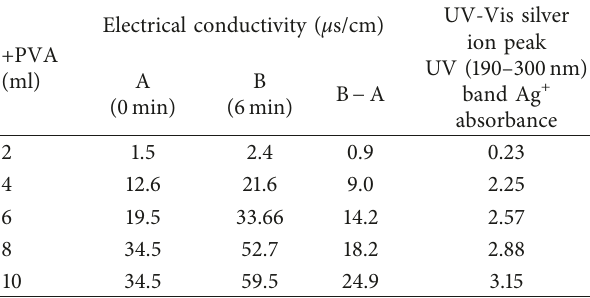
Table 2: The measured electrical conductivity versus UV-Vis Ag + absorbance at 190–300nm band.